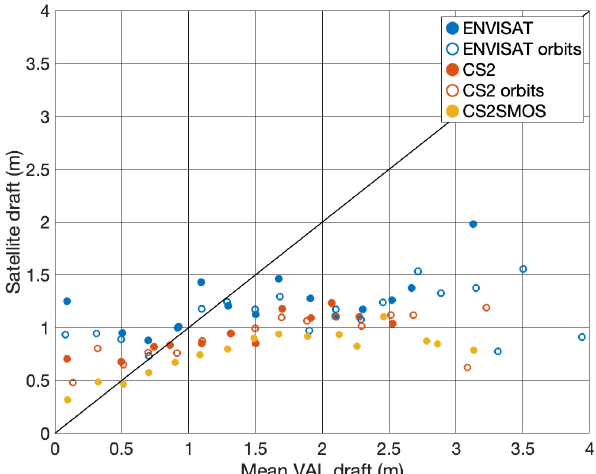
Figure 5. Mean sea ice drafts per 0.2m VAL data bin from ENVISAT (filled blue circles), ENVISATorbit (blue circles), CS2 (filled orange circles), CS2orbit (orange circles) and CS2SMOS (filled yellow circles) data products.